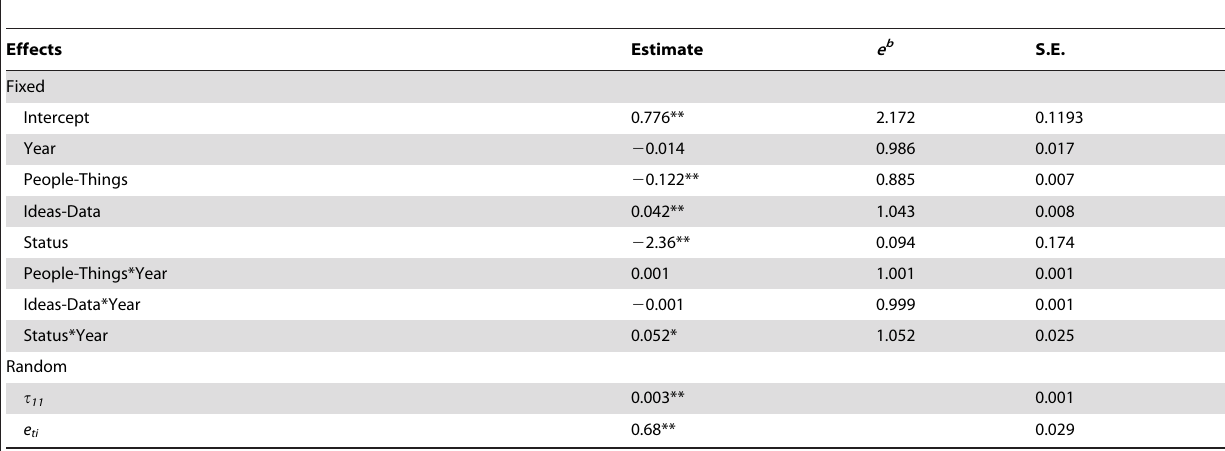
Table 2. Fixed and random effects of Model 1, which predicted the change in percent of women in an occupation from O*NET- based measures of occupations’ people-things orientation, data-ideas orientation, and status.